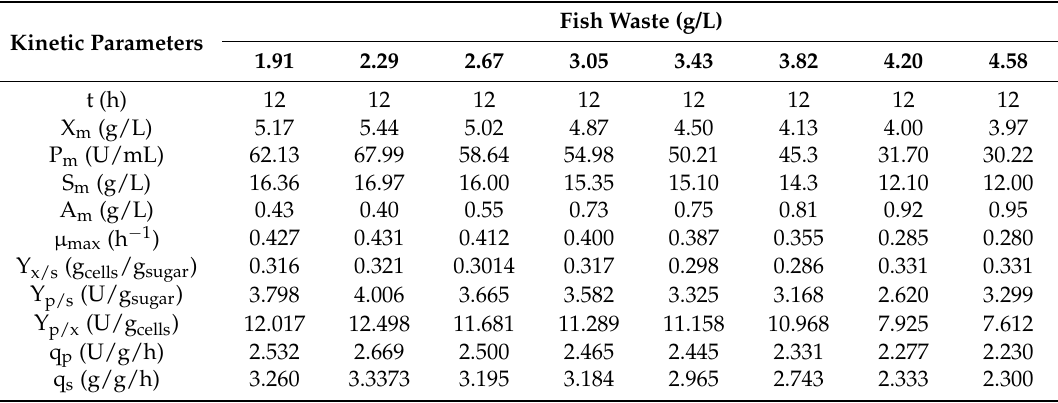
Table 3. Batch Fermentation Kinetics of T1 Lipase Production by the Recombinant E. coli Using Different Fish Waste Percentages in Shake